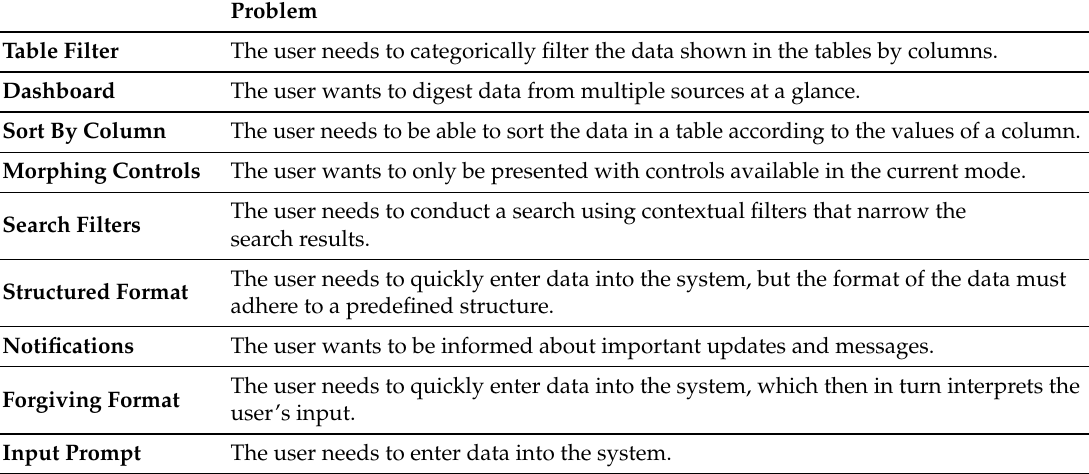
Table 1. Patterns